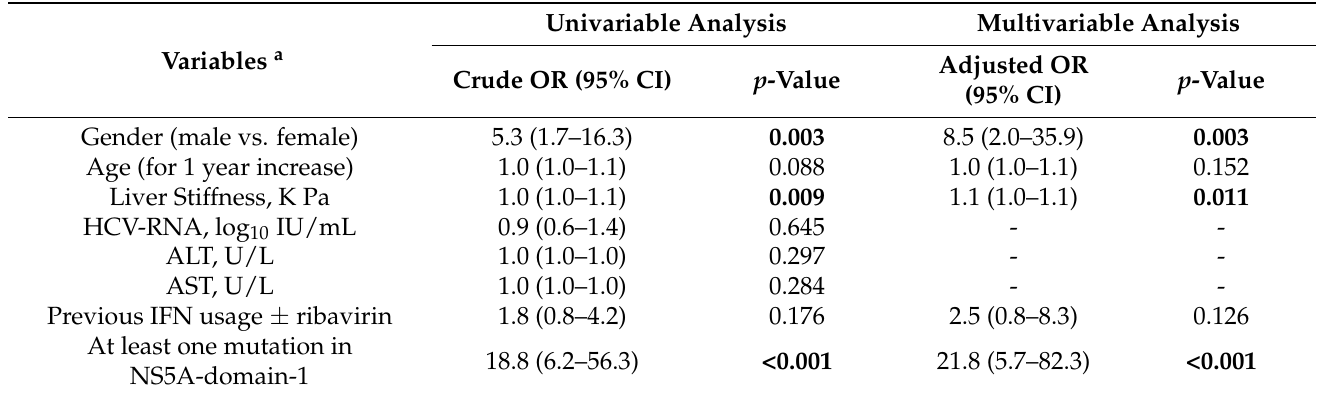
Table 2. Factors associated with HCV-related HCC by multivariable logistic regression